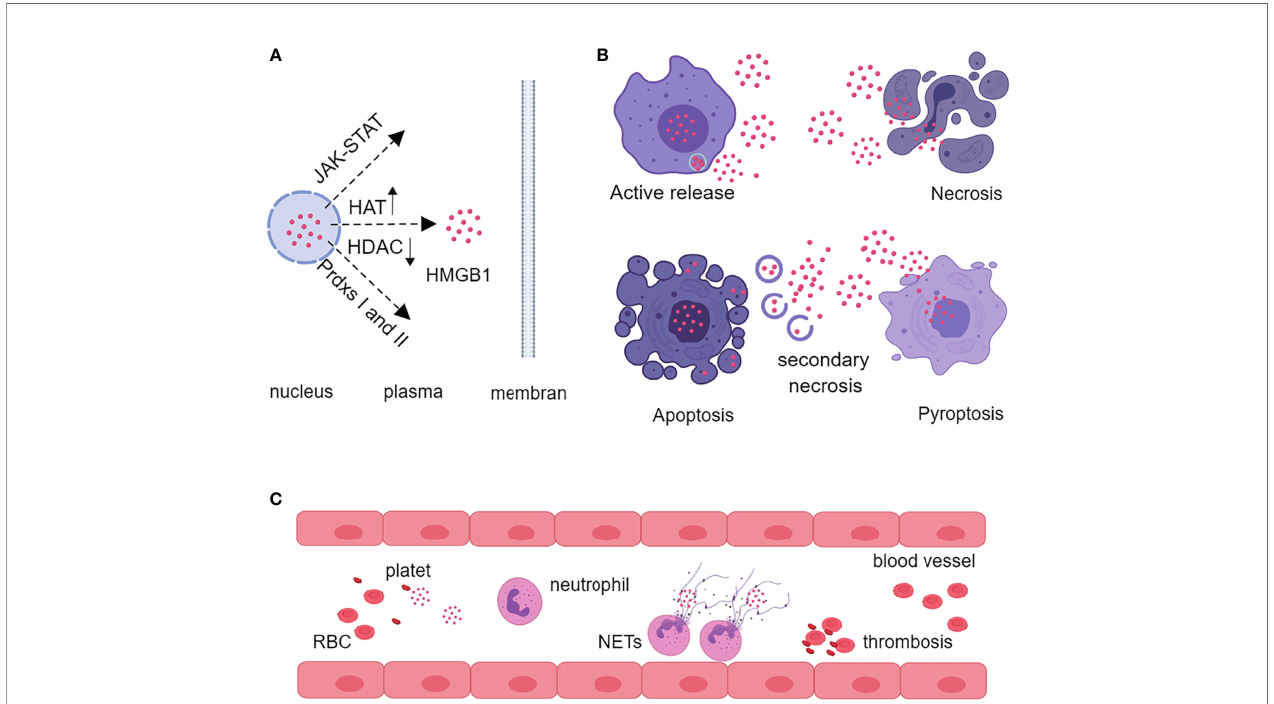
FIGURE 2 | Characteristics of HMGB1 release. (A) HMGB1 is translocated from the nucleus to the cytoplasm by the JAK-STAT pathway, by increasing the activity of HAT and decreasing the activity of HDAC, or by oxidation of nuclear peroxiredoxins I or II. (B) Activated in fl ammatory cells can actively secrete HMGB1 through the lysosomal pathway. Necrosis, pyroptosis, and secondary necrosis following apoptosis can also release HMGB1. (C) Activated platelets produce large amounts of HMGB1 to promote thrombosis and neutrophil release of NETs. HAT, histone acetylase; HDAC, histone deacetylase; Prdxs, peroxiredoxins; RBC, red blood cell; NETs, neutrophil extracellular